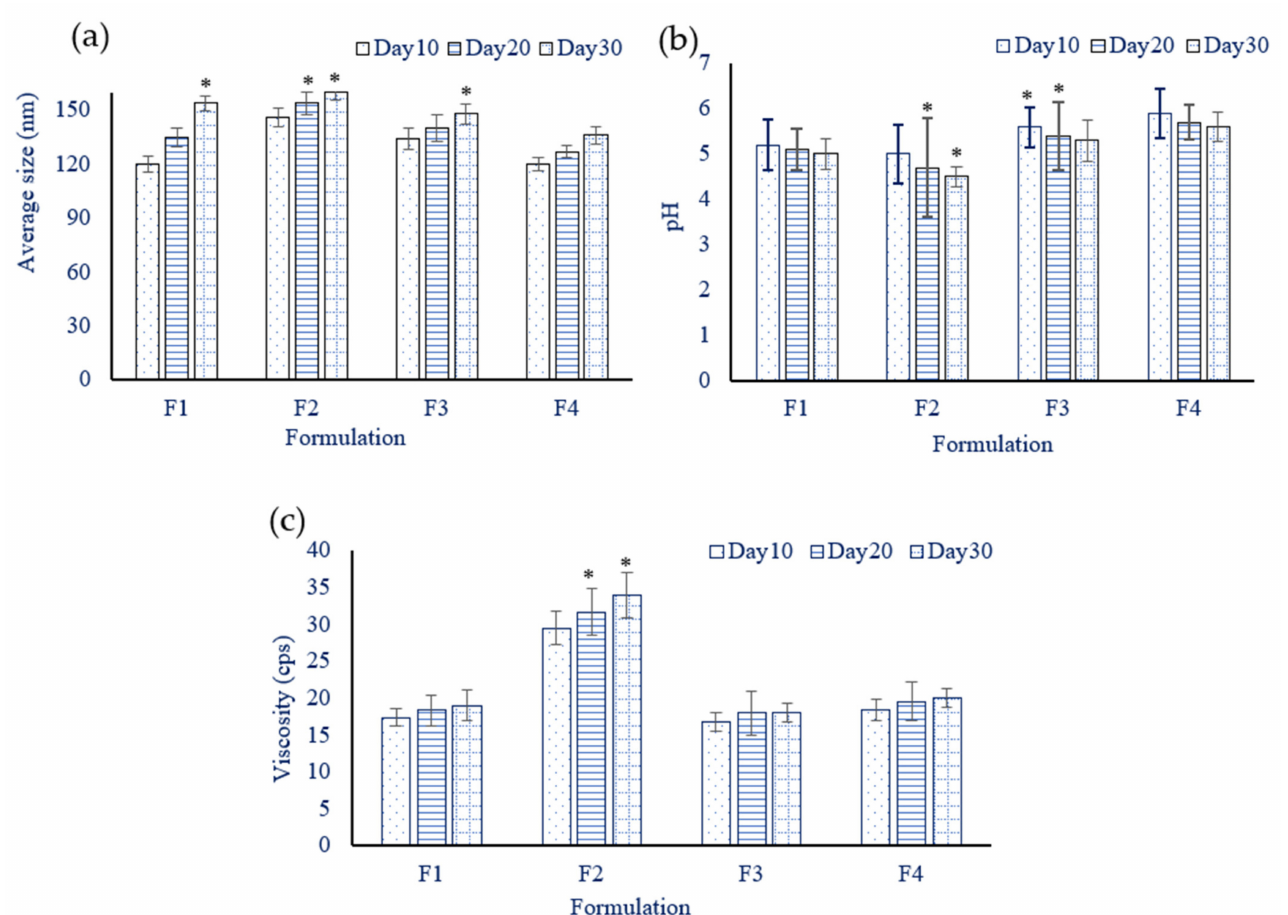
Figure 2. The size of the emulsions containing 5-FU ( a ), variations in the pH of the emulsions containing 5-FU ( b ) and the viscosity of the emulsions containing 5-FU ( c ), data are expressed as mean ± S.D, n = 3, * denotes ( p < 0.01) statistical significance.